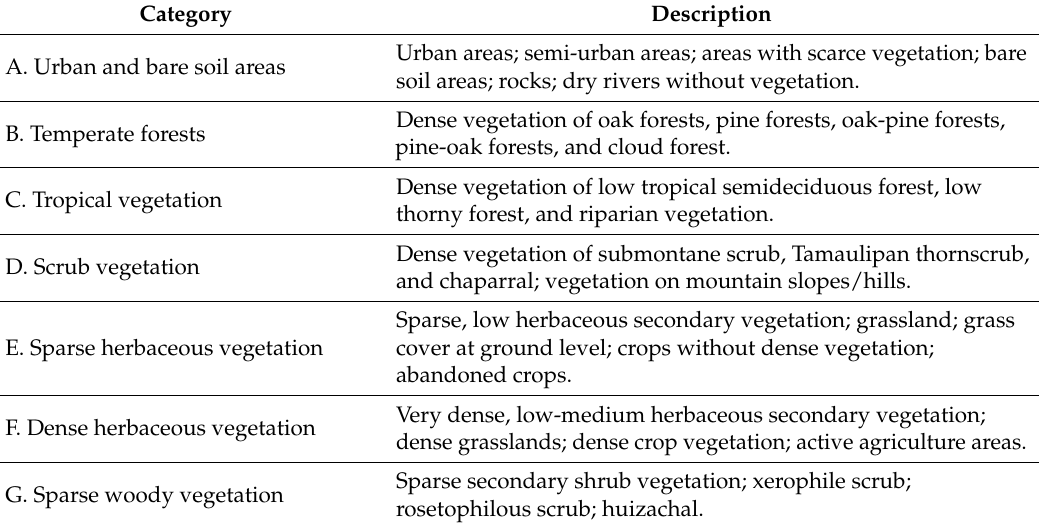
Table 2. Land use-cover (LULC) categories, Natural Protected Area Altas Cumbres and adjacent areas. Tamaulipas,